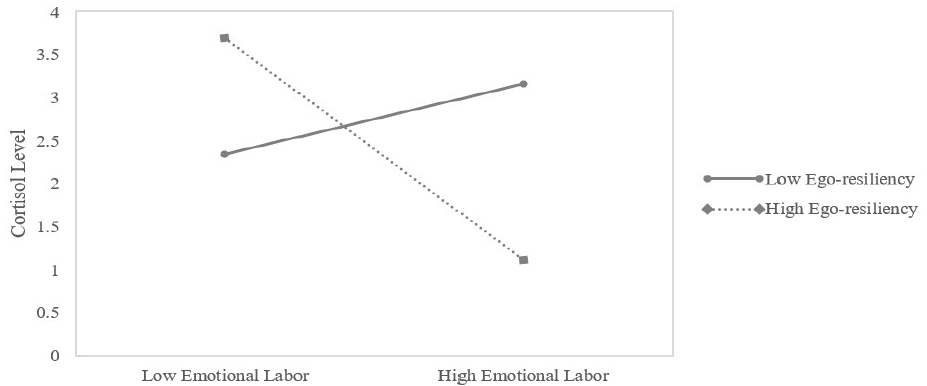
Figure 1. Interaction effect of emotional labor and ego-resiliency on change in cortisol levels.